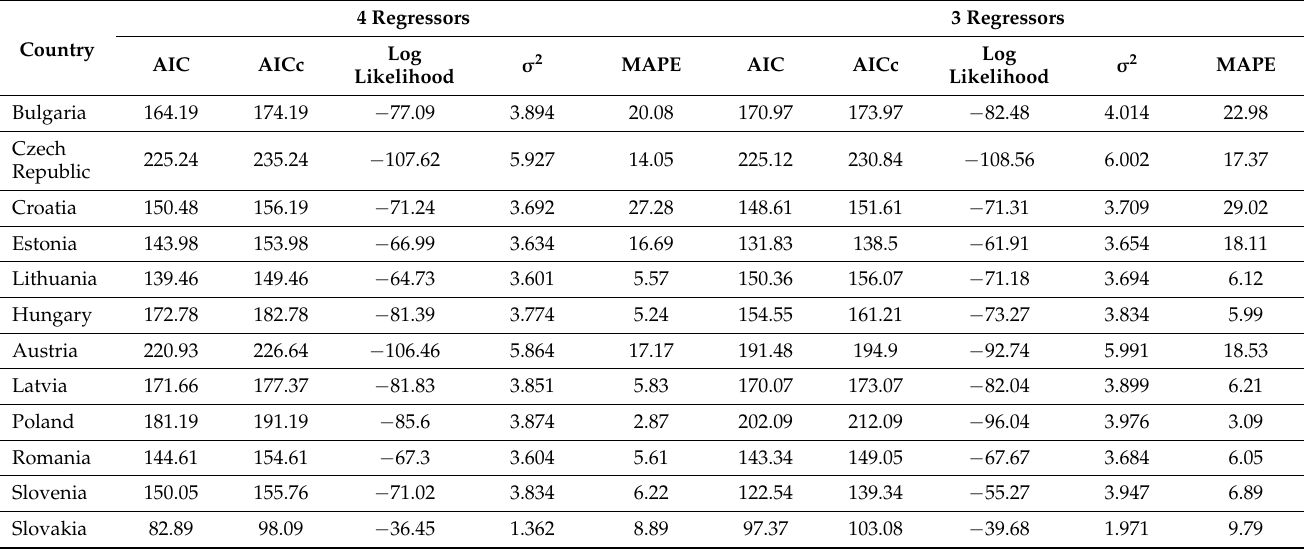
Table 3. The quality of ARIMA (0,0,0)